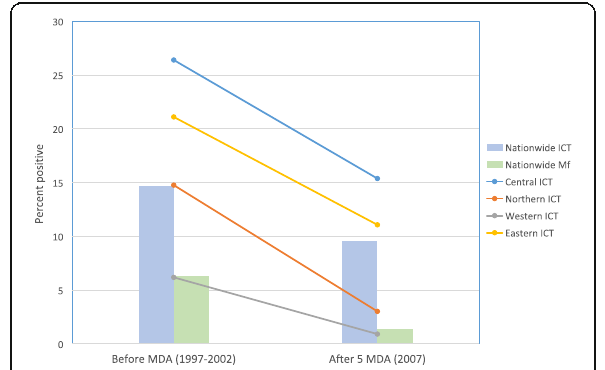
Fig. 2 Prevalence of antigen and Mf positives before and after 5 rounds of MDA. Note: nationwide ICT prevalence before MDA is average of all antigen prevalence results in 1997 – 2001 and 2002. Northern Province was not surveyed in 2002. Mf prevalence data are only available for 2002 (excludes Northern Province) and 2007. See Table 4